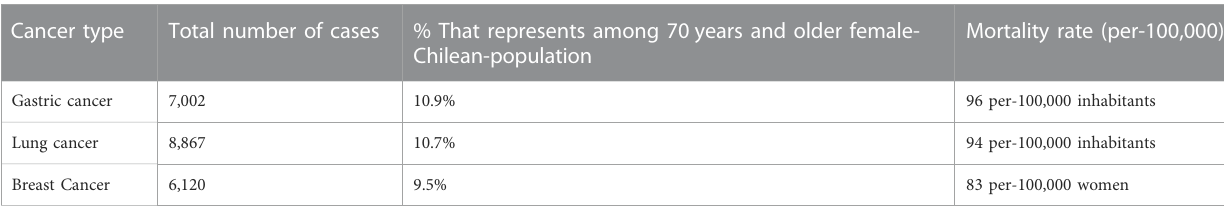
TABLE 2 Main types of malignant tumors excluding non-melanoma skin cancer, total number of cases, percentage representing among 70 years and older population, mortality rate, in Chilean female population during the period 2009 – 2018. Cancer